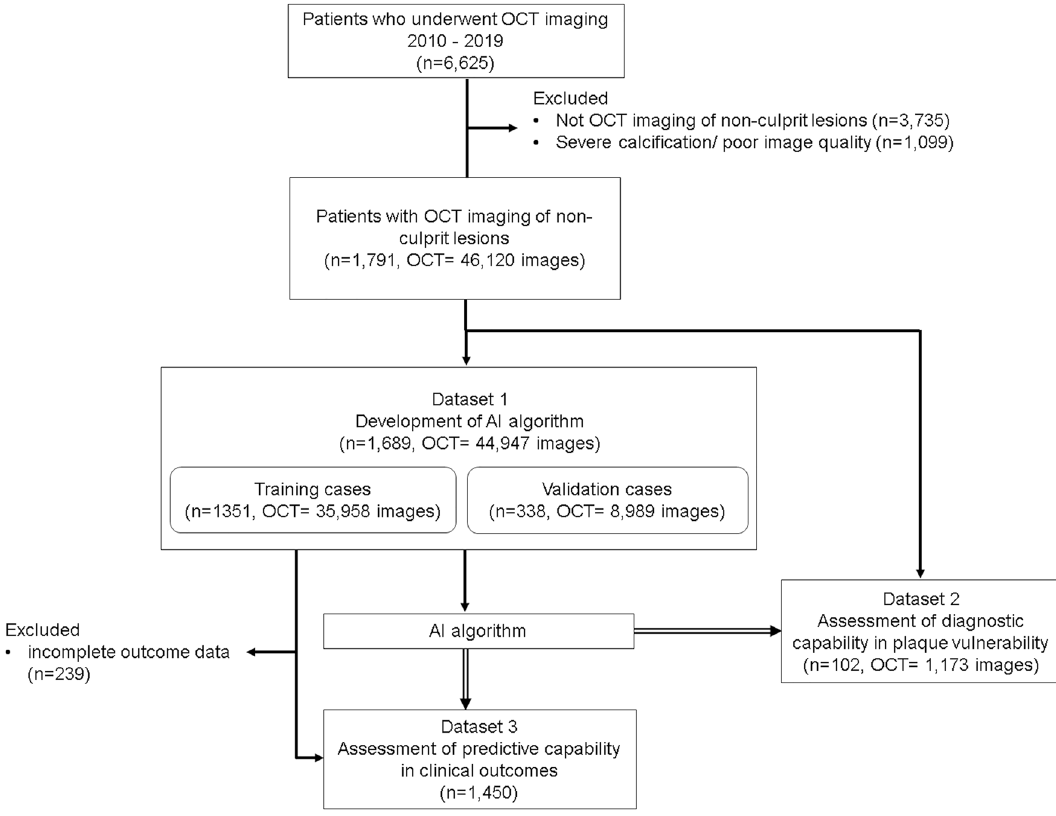
Figure 1. Study flow chart. OCT optical coherence tomography, AI artificial